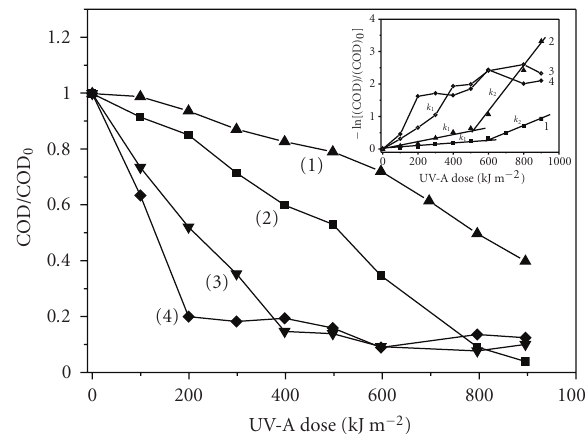
Figure 5: Dependence between the hydroxyl radicals quantum yield and the amount of zinc phthalocyanine adsorbed on TiO 2 .